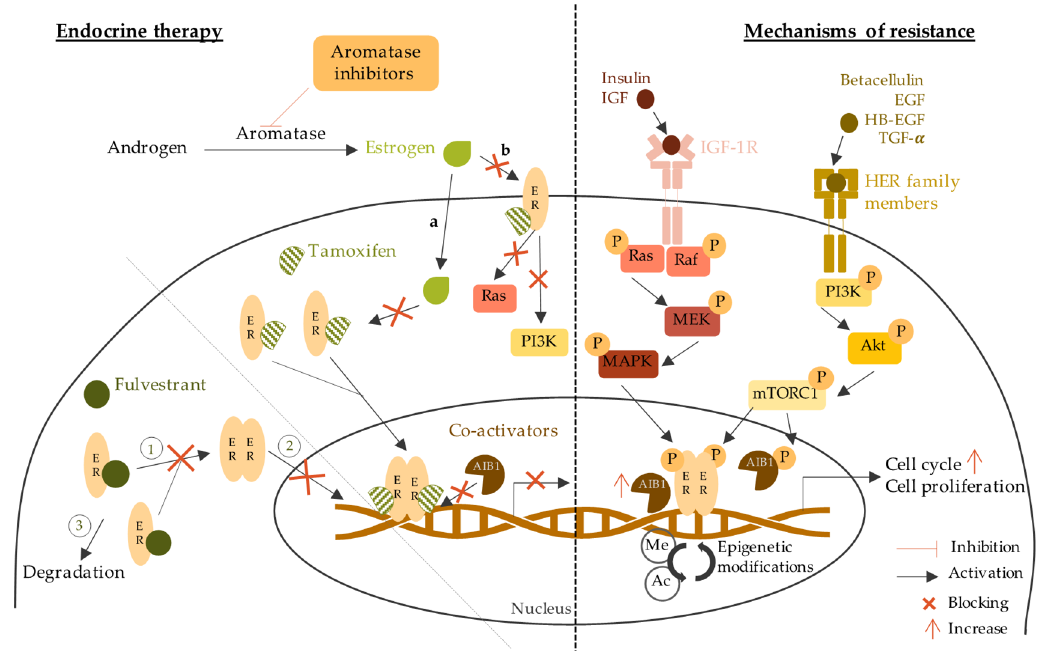
Figure 3. Endocrine therapy mechanisms of action and resistance. The left part of the figure shows the mechanism of endocrine therapy through aromatase inhibitors, tamoxifen, and fulvestrant. The right part of the figure describes the mechanisms of resistance to endocrine therapy through the epigenetic modifications, the increase of coactivators and cell cycle actors, and the activation of other signaling pathways. Estrogens can go through the plasma membrane by a. diffusion as they are small non-polar lipid soluble molecules; b. binding to membrane ER initiating the activation of Ras/Raf/MAPK and PI3K/Akt signaling pathways which are blocked by tamoxifen. 1: inhibition of ER dimerization; 2: blockage of nucleus access; 3: ER degradation. ER: estrogen receptor; AIB1: amplified in breast cancer 1; IGF-1R: insulin growth factor receptor 1; IGF: insulin growth factor; HER: human epidermal receptors; EGF: epidermal growth factor; HB-EGF: heparin-binding EGF-like growth factor; TGF- α : transforming growth factor alpha; MEK/MAPK: mitogen activated protein kinase; PI3K: phosphoinositide 3-kinase; mTOR: mammalian target of rapamycin; Me: methylation; Ac: acetylation.